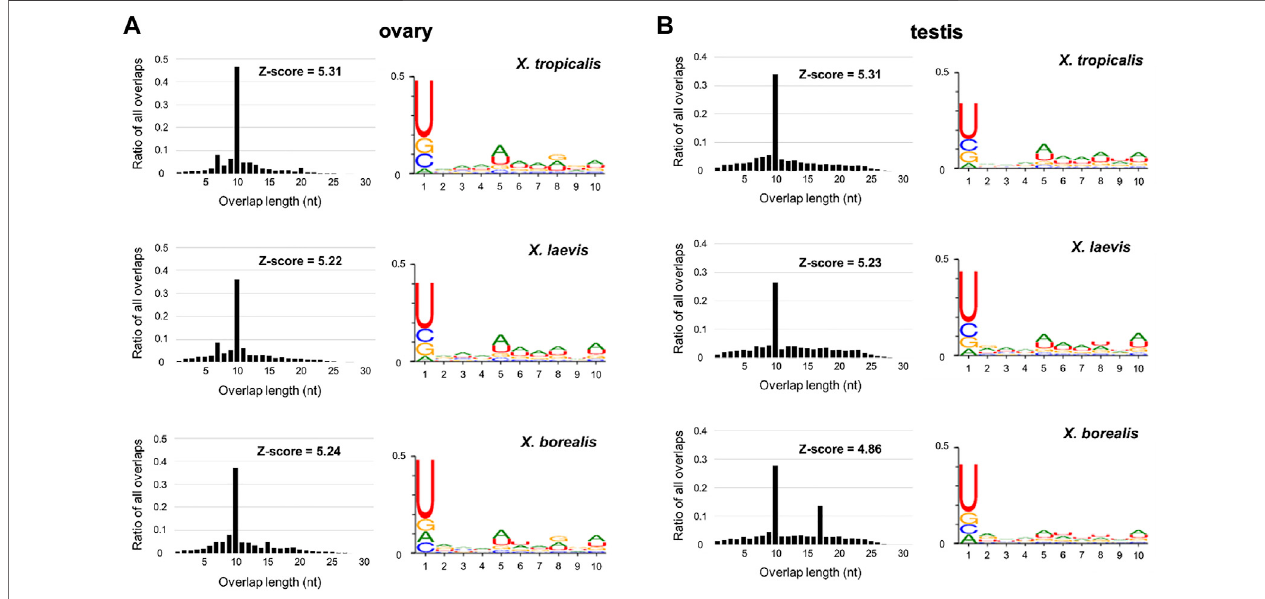
FIGURE 2 | Sequence characterization of ovarian and testicular piRNAs in the three Xenopus species, X. tropicalis , X. laevis , and X. borealis . Distributions of 5 ′ - overlap lengths (left) and 1 U/10 A bias (right) on piRNA molecules transcribed in ovaries (A) and testes (B) . The amounts of piRNAs were normalized by 10 7 /mapped piRNA counts in length distribution. Numbers of sequence types of piRNAs transcribed in testes and ovaries are shown in Venn diagrams (C) .